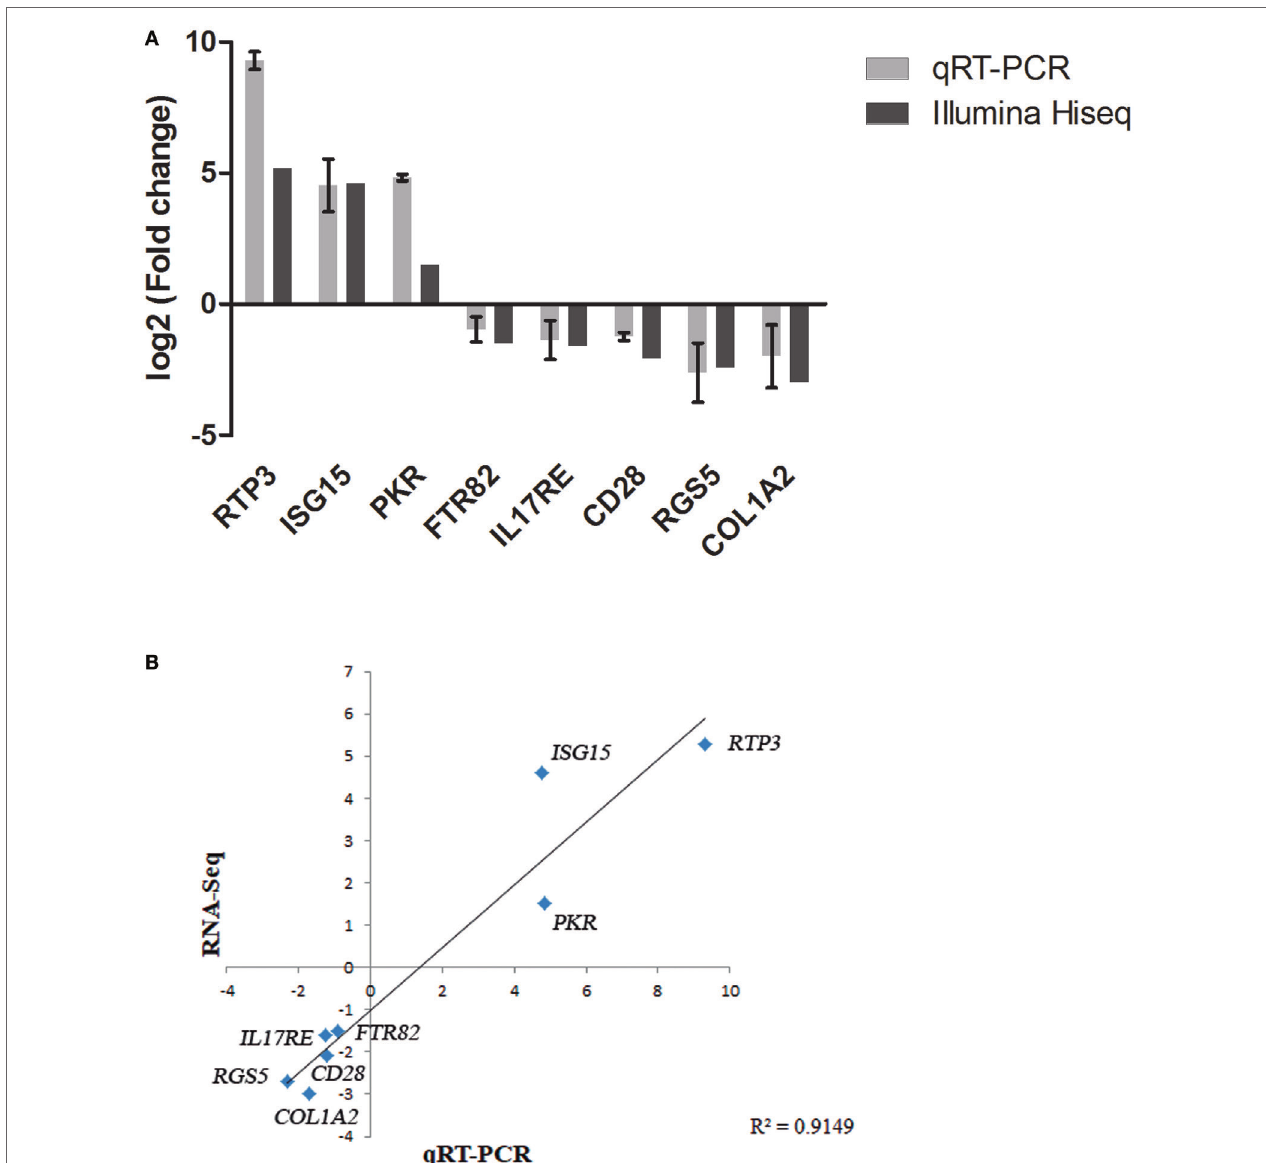
FigUre 4 | Validation of RNA-Seq data by quantitative real-time PCR (qRT-PCR). (a) Comparison of the expressions profile of eight DEGs determined by Illumina HiSeq ™ 2000 sequencing platform and qRT-PCR at 48 h (pi) using ribosomal protein subunit S4 ( rps4 ) as housekeeping gene. Data shown are the mean of triplicates ± SD. (b) Correlation of data between RNA-Seq and qRT-PCR